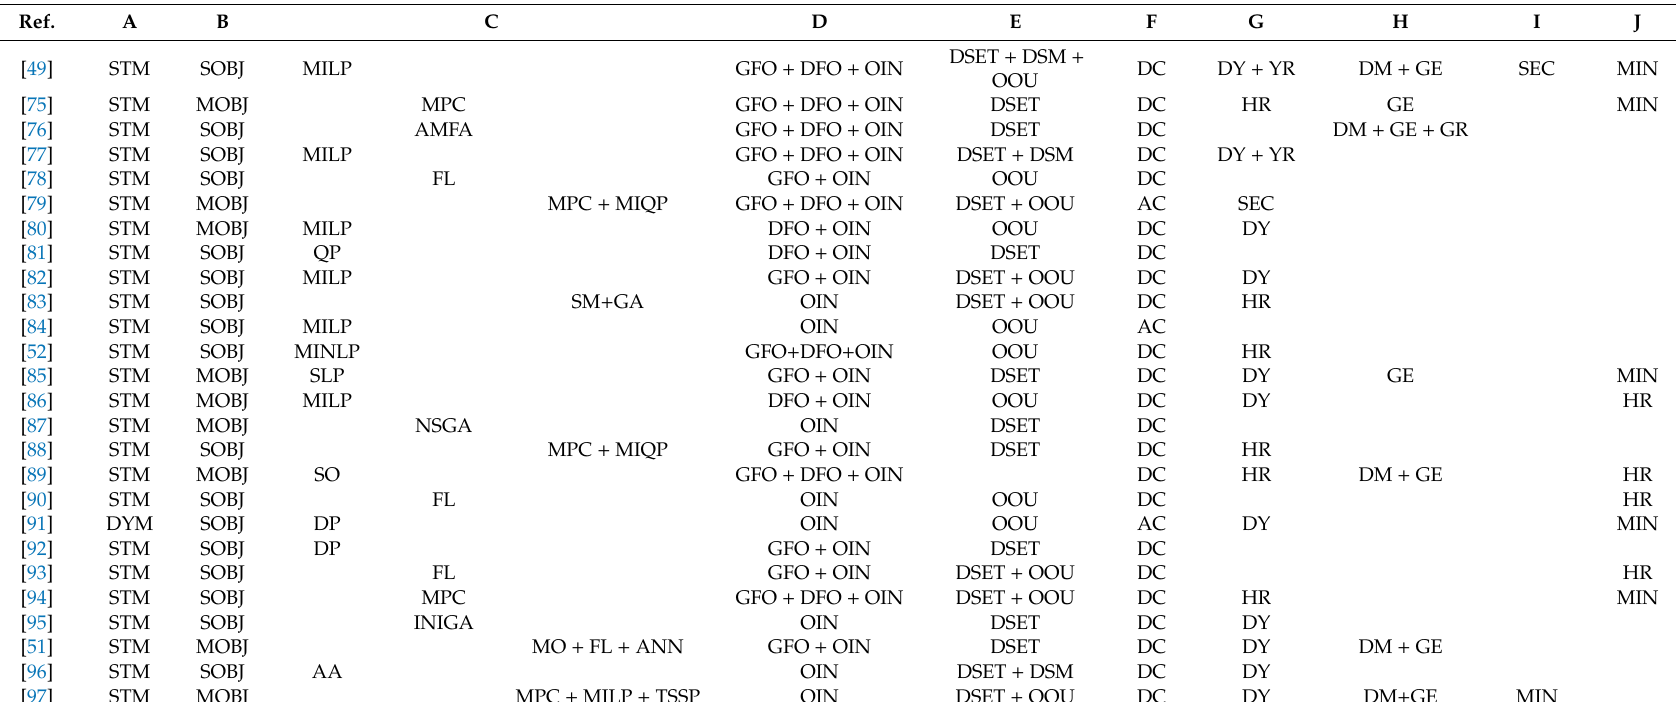
Table A5. Papers published in